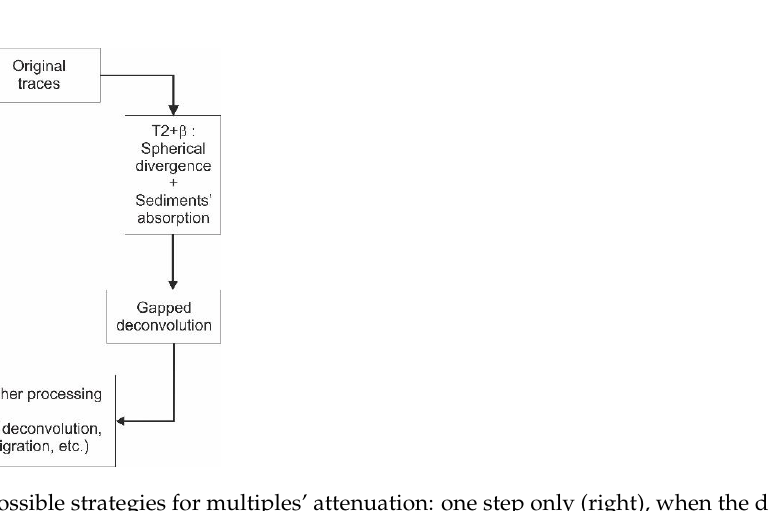
Figure 9. Normalized amplitude spectra for two intersecting profiles with enveloped Chirp ( a ) and enveloped Boomer data ( b ) plotted by continuous blue lines in a logarithmic scale. The approximating function | ω | β is represented by the dotted orange line. Notice the different b values in the two cases, and the closer match of the enveloped Boomer data ( b ) to the approximating function.